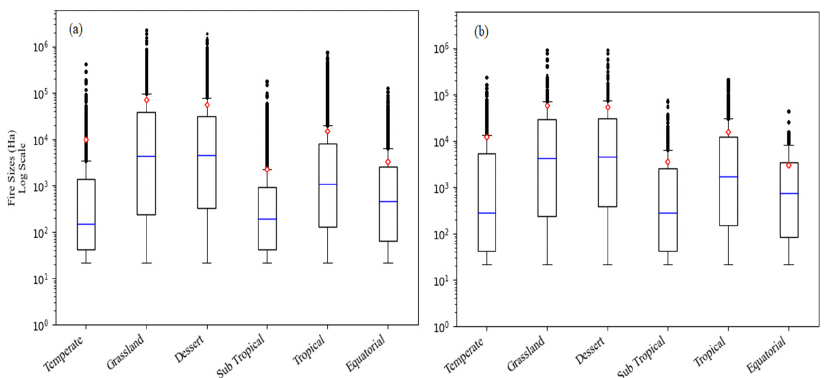
Figure 3. Fire size samples shown on log10 scale for six climate zones across Australia, extracted from fire seasons: ( a ) 2000–2016 (model development); ( b ) 2017–2020 (model evaluation). The lower and upper boundary of boxes represent 25th and 75th percentiles, respectively. Whiskers extended to 1.5 times interquartile ranges. The blue line in boxes represent median, red diamonds represent mean fire size and black circular dots represent outliers.